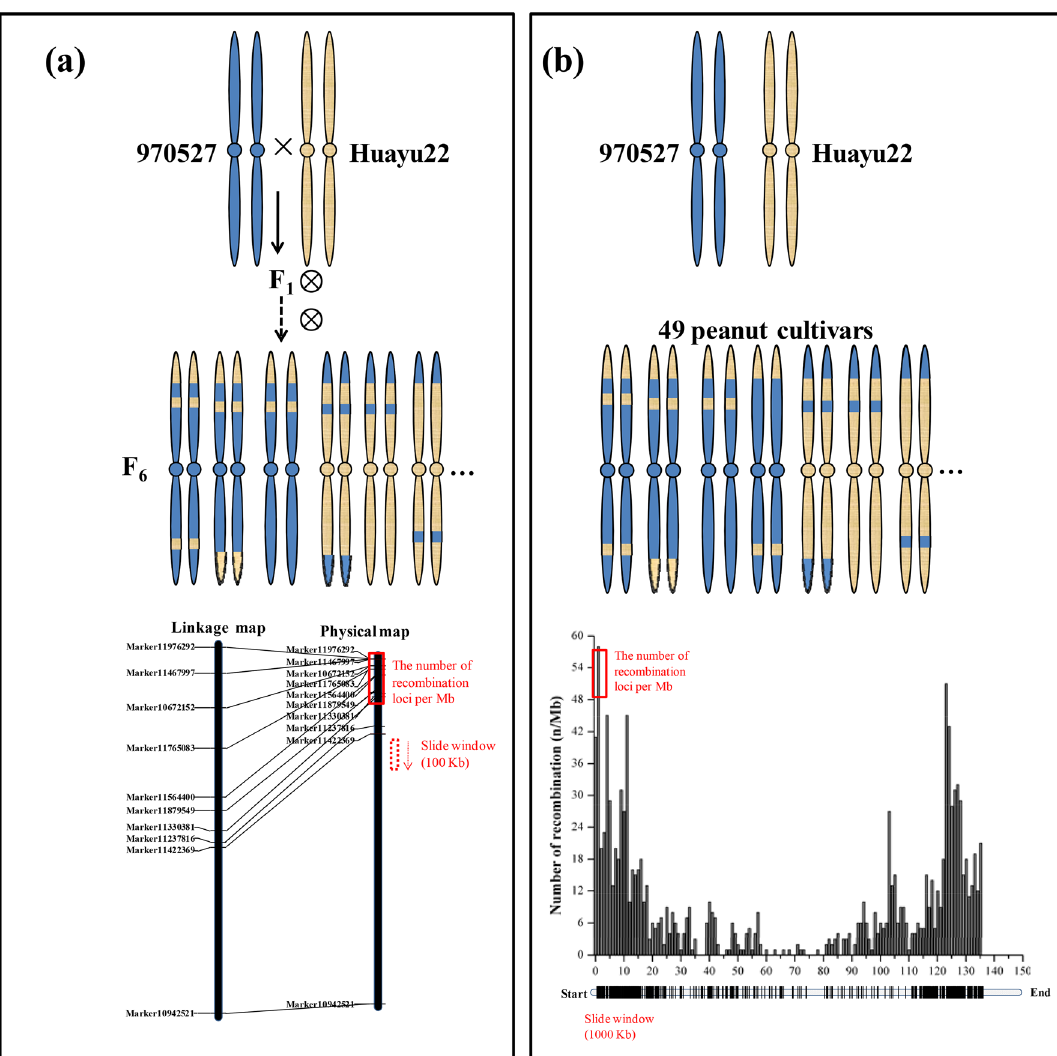
identification of crossover events and recombination hot spots detection in 49 peanut